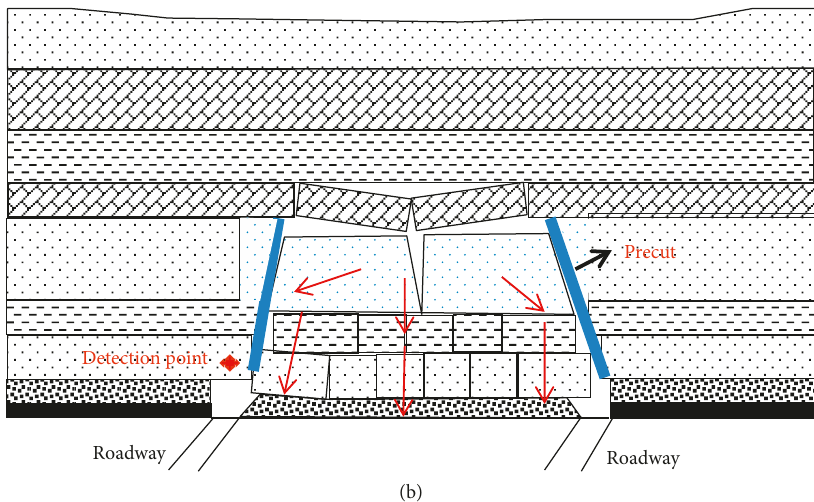
Figure 8: Model illustrating structures formed within overburden and dynamic evolution process of roadway roof stress in the conventional mining method and gob-side entry retaining through precut overhanging hard roof method. (a) The conventional mining method. (b) The gob-side entry retaining through precut overhanging hard roof method.